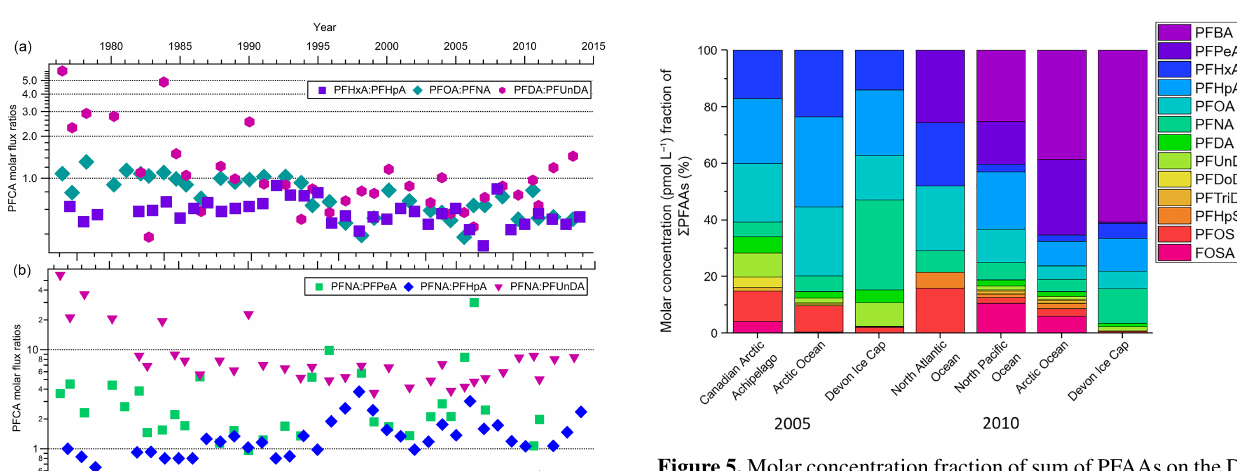
Figure 5. Molar concentration fraction of sum of PFAAs on the De- von Ice Cap (from the current 2015 ice core collection) compared to levels in the Canadian Arctic Archipelago (Benskin et al., 2012b), Arctic Ocean (Benskin et al., 2012b; Cai et al., 2012a), North At- lantic Ocean (Zhao et al., 2012), and North Pacific Ocean (Cai et al., 2012a) in 2005 and 2010. Ocean concentrations are compared to ice cap concentrations for two years to show a better overall com- parison with different ocean samples that were collected in multiple field